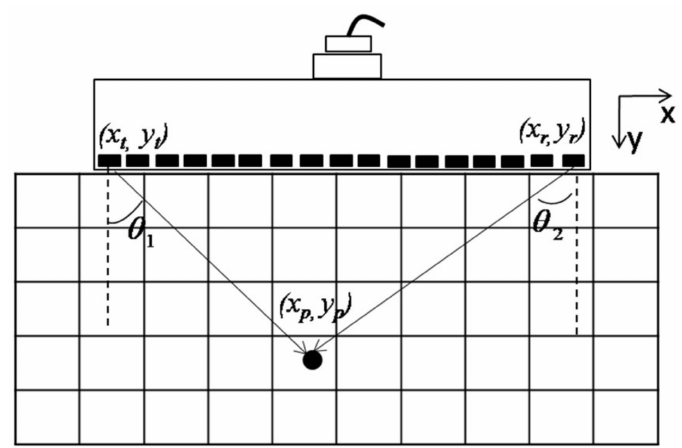
Figure 1. Schematic of TFM